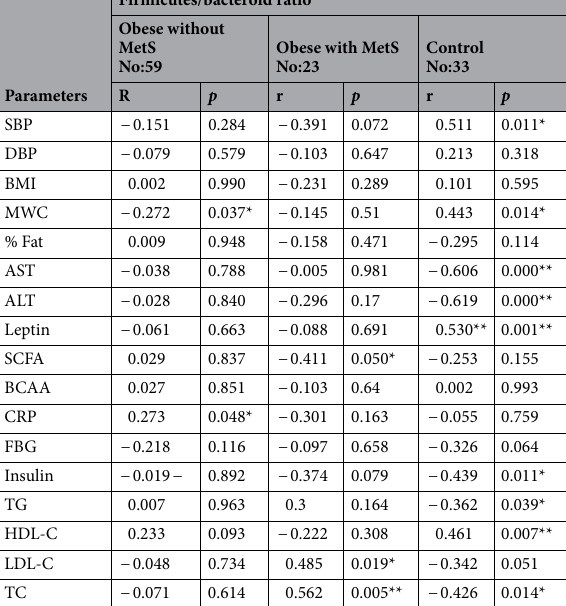
Log Log Lactobasillus Bifidobacterium Log Bacteroidetes Log Firmicutes